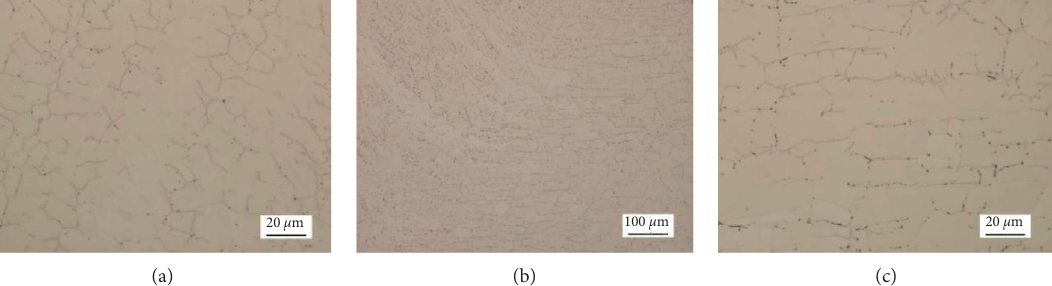
Figure 6: Microstructure of welded joint with shielding gas of 95%Ar+ 5%CO